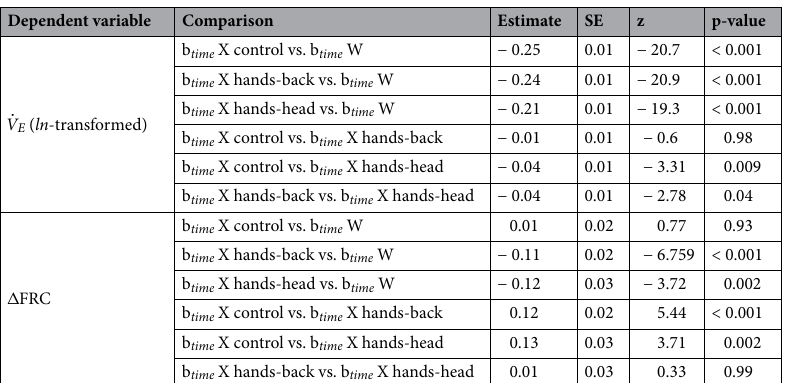
Table 6. Analysis of changes in breathing during post-exercise weighted restraint (phase X). The table presents statistical tests of contrasts from mixed-effects regression models where b time represents slope over time. The analyses account for a subject’s age, BMI, and experimental phase in the fixed effects, and include a random effect of subject identity to account for repeated measures (n = 2441 breaths from 17 subjects in the W and ˙ V X phases). To appropriately model the variances, E is ln -transformed, and the analysis for (cid:31) FRC accounts for unequal variance across treatments. W = weighted prone (prior to exercise); X = weighted prone in the restraint posture (post-exercise); control = posture with arms at side; hands-back = restraint with hands behind back; hands-head = restraint posture with hands behind head.